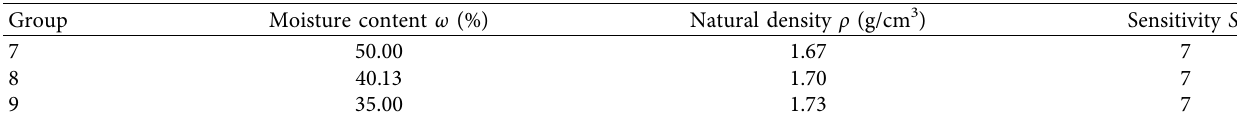
Table 10: The physical and mechanical indexes of clay of the literature [24].